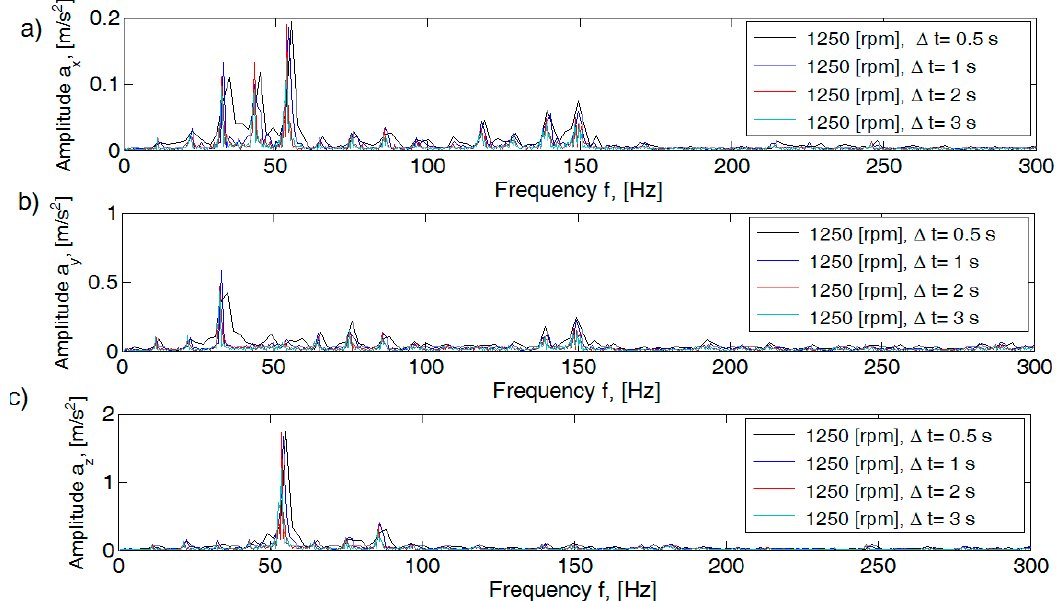
Figure 6. Amplitude spectra for assumed time intervals Δ t: ( a ) along x axis; ( b ) along y axis; ( c ) along z axis